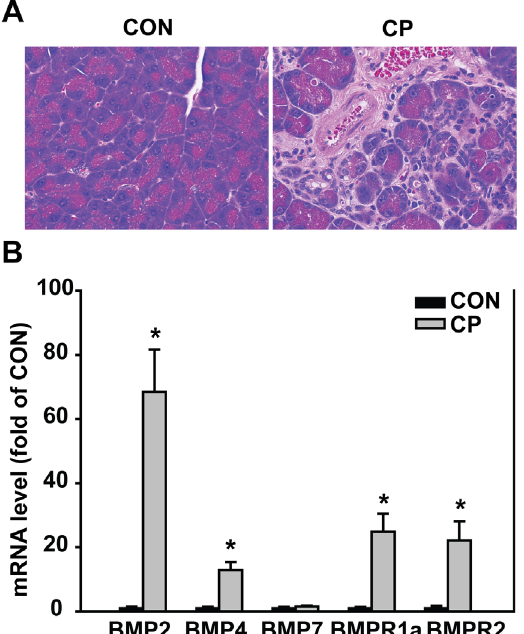
Figure 1. Expression of BMP signaling molecules increased in the pancreas under CP induction. (A) Representative images of H&E staining. Original magnification 6 400. (B) mRNA expression of BMP2, BMP4, BMP7, BMPR1a and BMPR2. The mRNA levels were normalized against 18s and quantified as fold of control (CON). * P , 0.05 compared with CON. CON mice: n=4, CP mice: